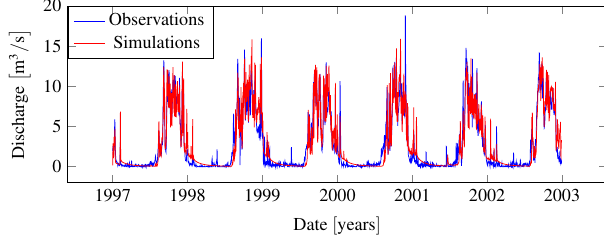
Figure 7. Simulation results compared to the observations for the calibration period from 1 October 1997 to 1 October 2003.